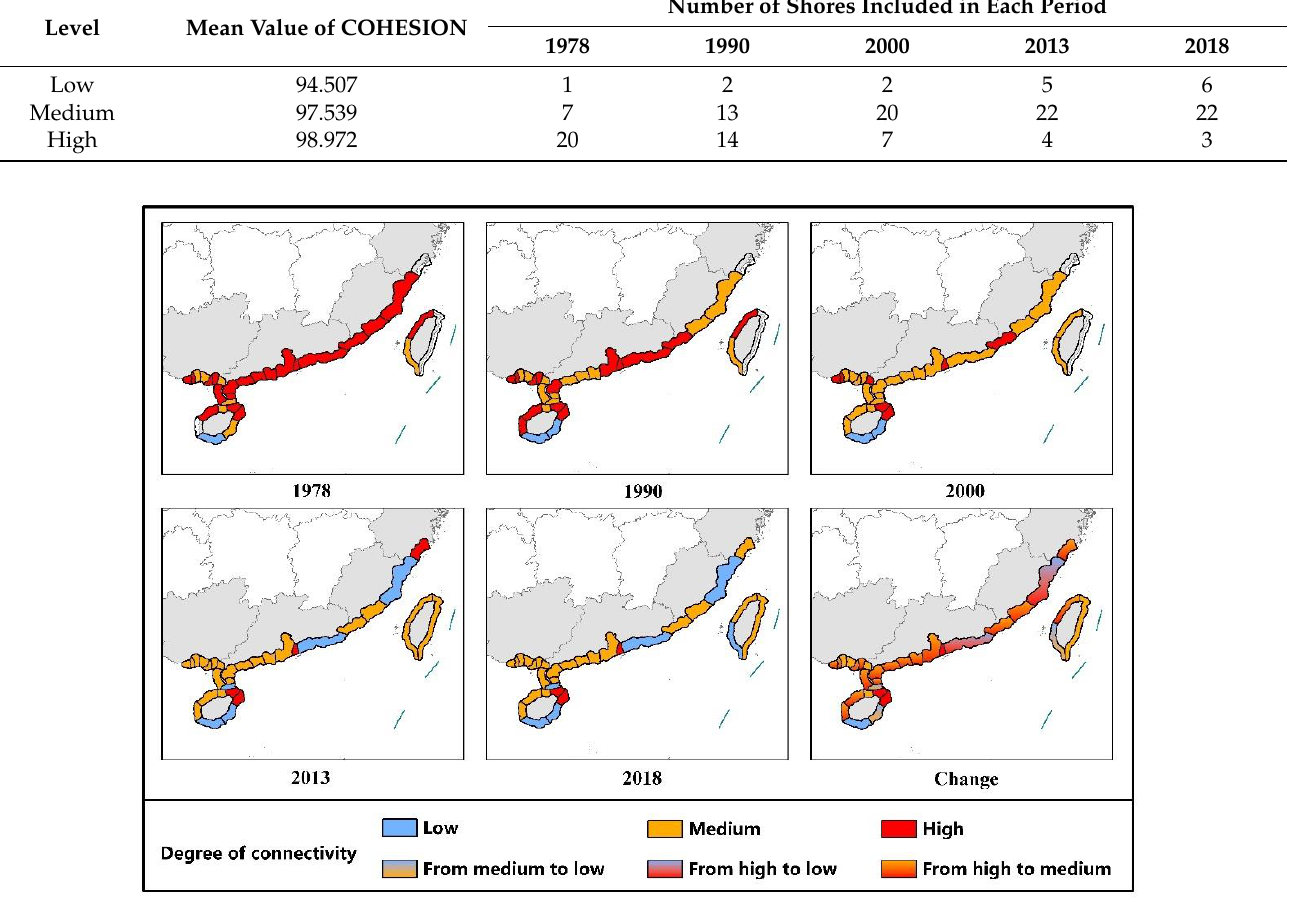
Figure 6. Temporal and spatial variations in the connectivity.